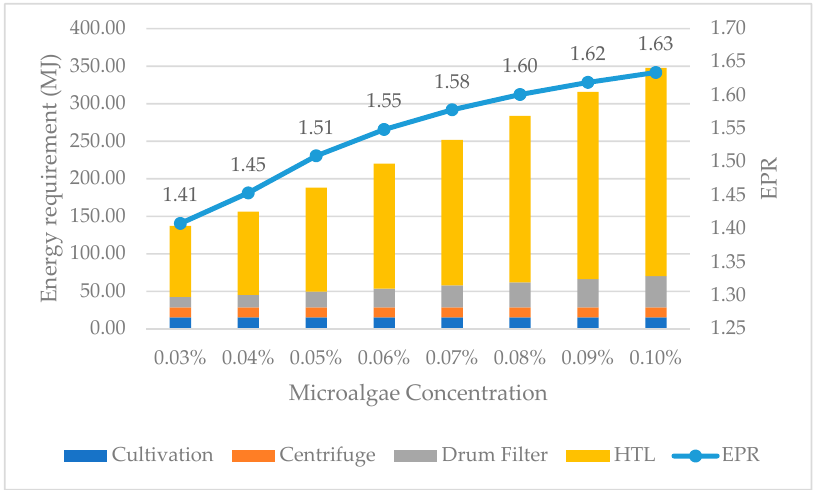
Figure 8. Energy profit ratio (EPR) for different microalgae concentrations.